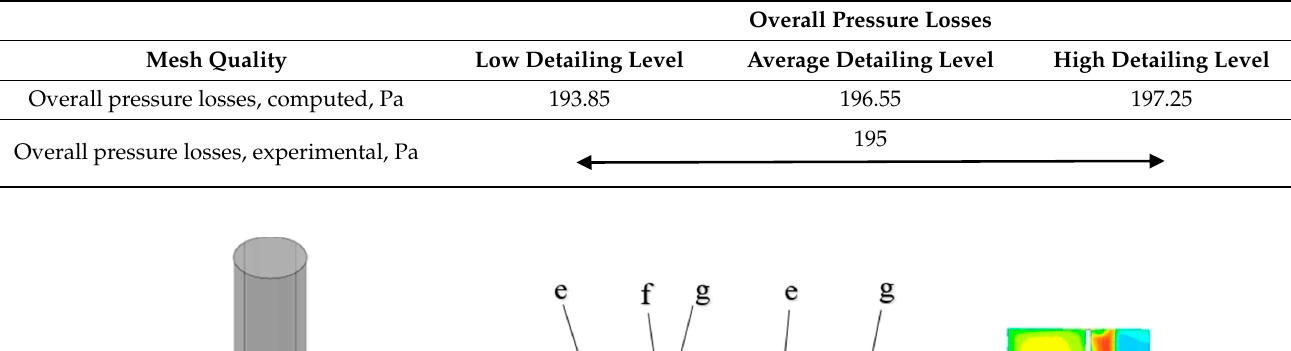
Table 1. Dependence of the overall pressure losses on the grid size at inflow rate 12 m/s.